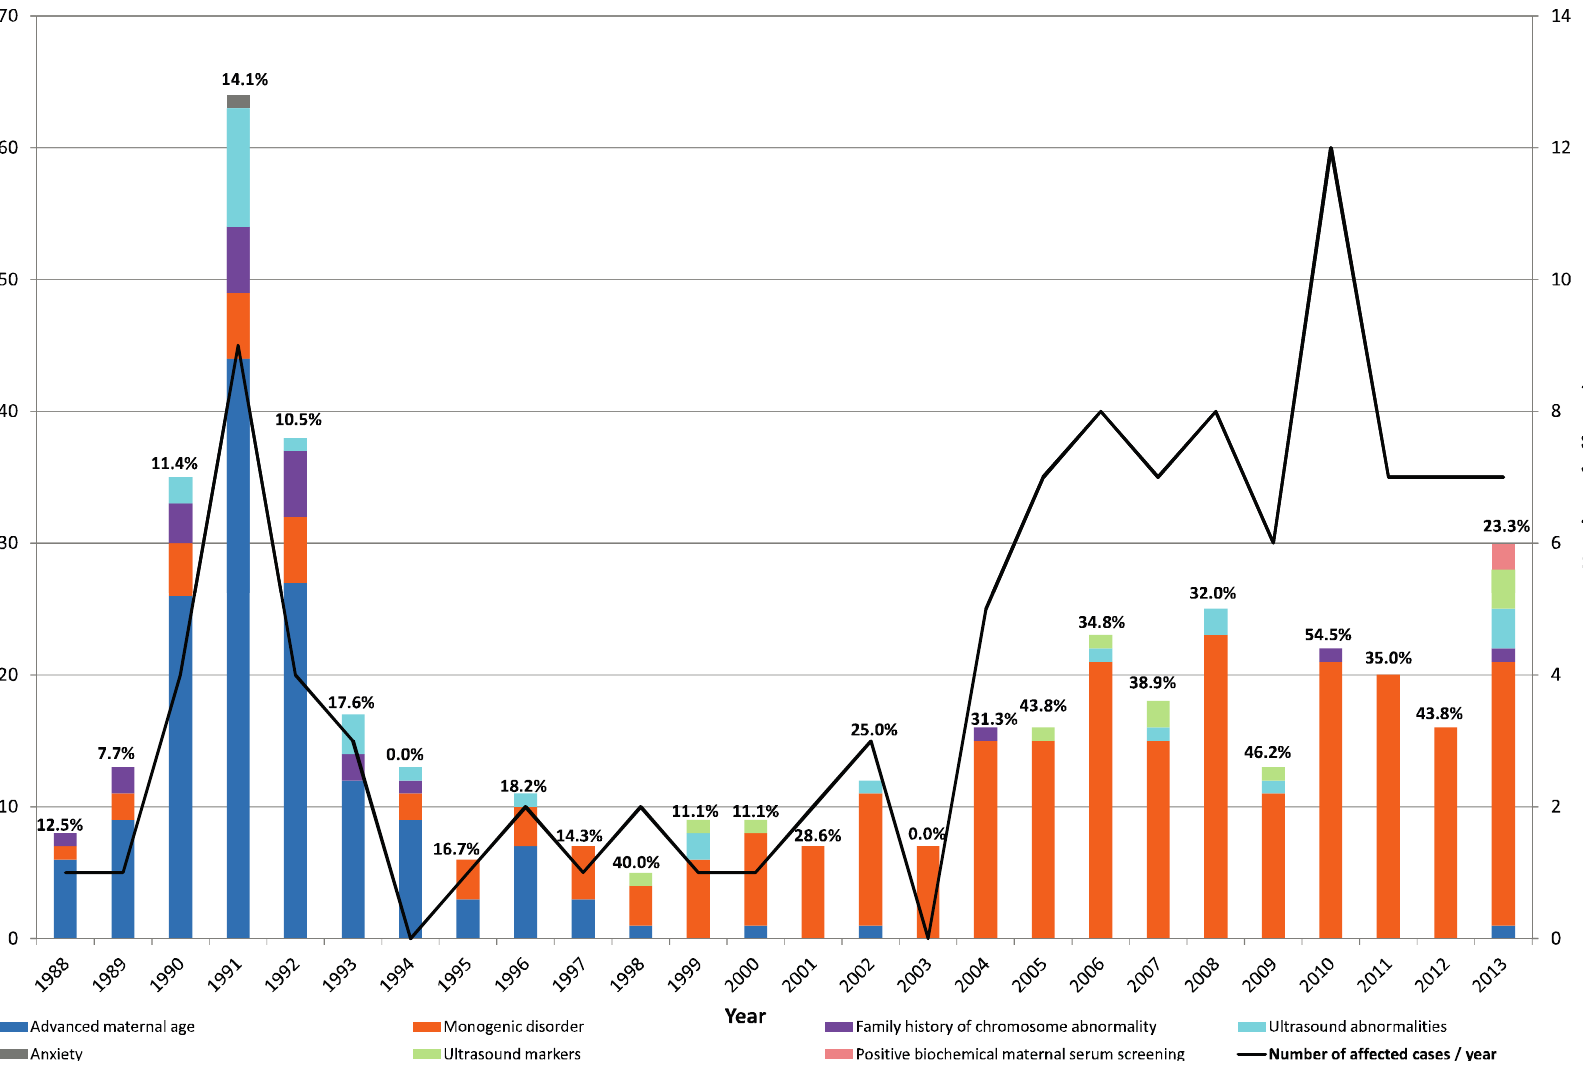
Figure 1. Annual variability of referral reasons among the 460 CVS. Number of referrals is represented in the Y -axis distributed by years, while the second Y -axis represents number of cases where a diagnosis was attained (affected). Percentage of affected cases per year is shown on